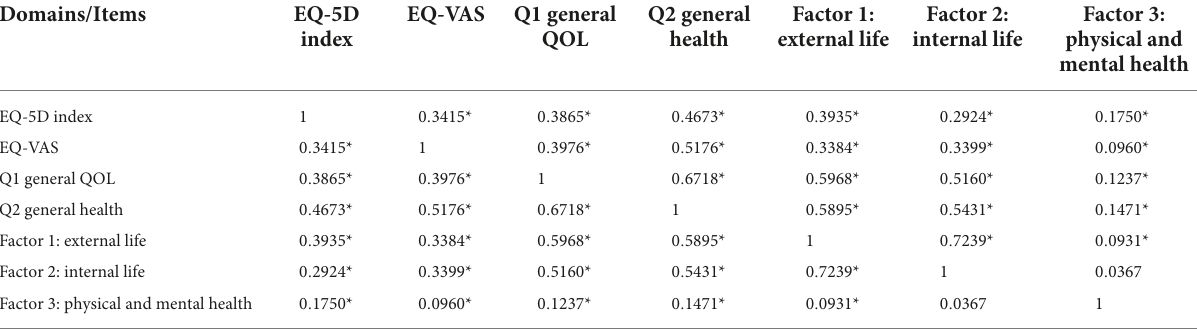
TABLE 6 Spearman’s correlation matrix with the WHOQOL-BREF instrument’s general quality of life satisfaction and general health satisfaction questions, EQ-5D index, and EQ-VAS to assess concurrent validity. Domains/Items